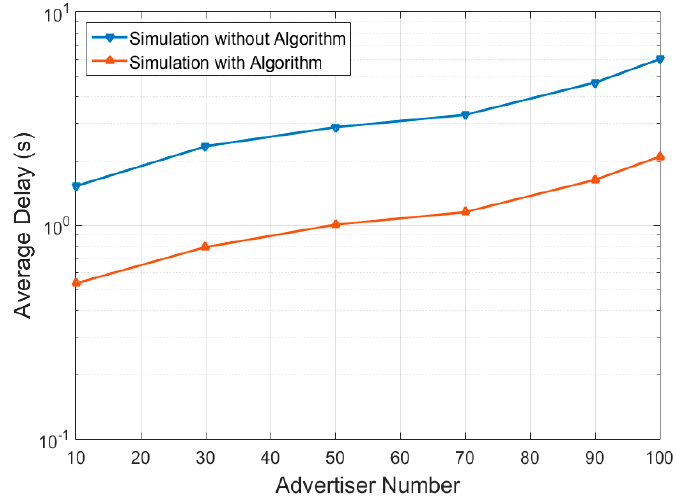
Figure 8. Total delay for advertiser discovery by the initiator.